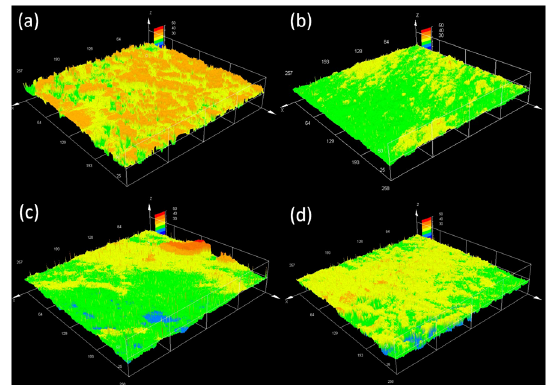
Figure 6. Confocal laser scanning microscopy (CLSM) showing the topography of collagen membrane submitted to the enzymatic activity of NanoBro and papain. ( a ) In a negative control corresponding to the membrane incubated with HEPES buffer; ( b ) positive control corresponding to collagen membrane incubated with papain; ( c , d ) collagen membrane incubated with NanoBro in the absence and in the presence of E-64. The images were obtained by vertical scanning of 50 µ M depth in horizontal planes between the surface and the maximum depth